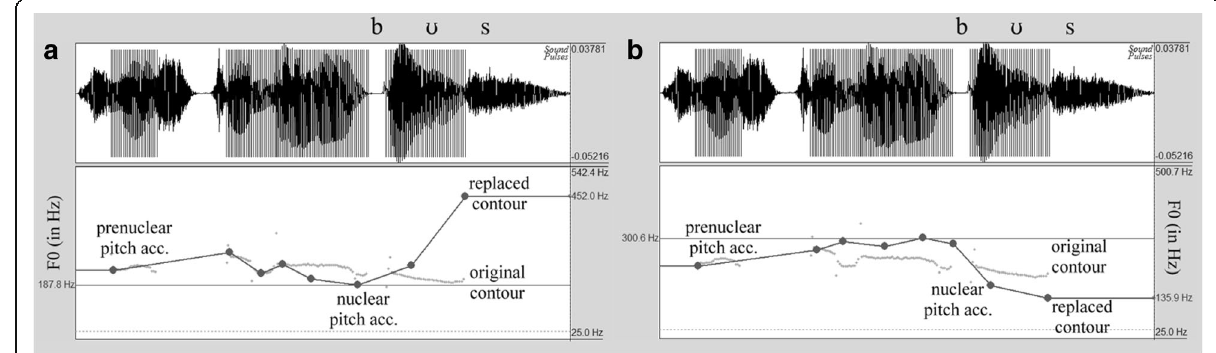
Fig. 5 Edited PRAAT screenshots of “ Siehst Du den Bus? ” (Do you see the bus?) showing the original (continuous) F0 contour ( gray dotted line ) and the two stylized tunes ( dark solid lines ) — rising to a high level in a and falling to a low level in b — that replaced the original F0 contour in each stimulus